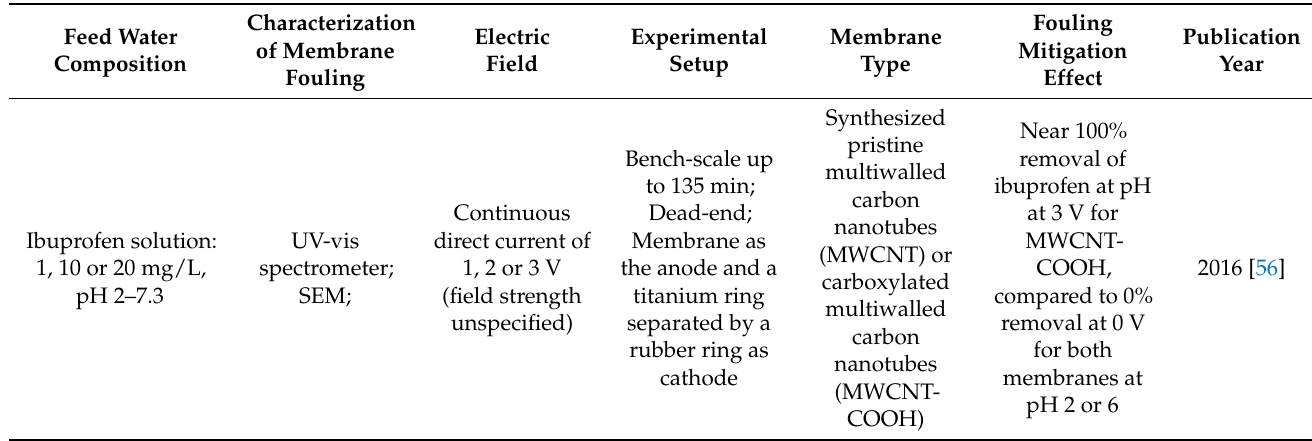
Table 3. Summary of electrofiltration studies for nanofiltration.